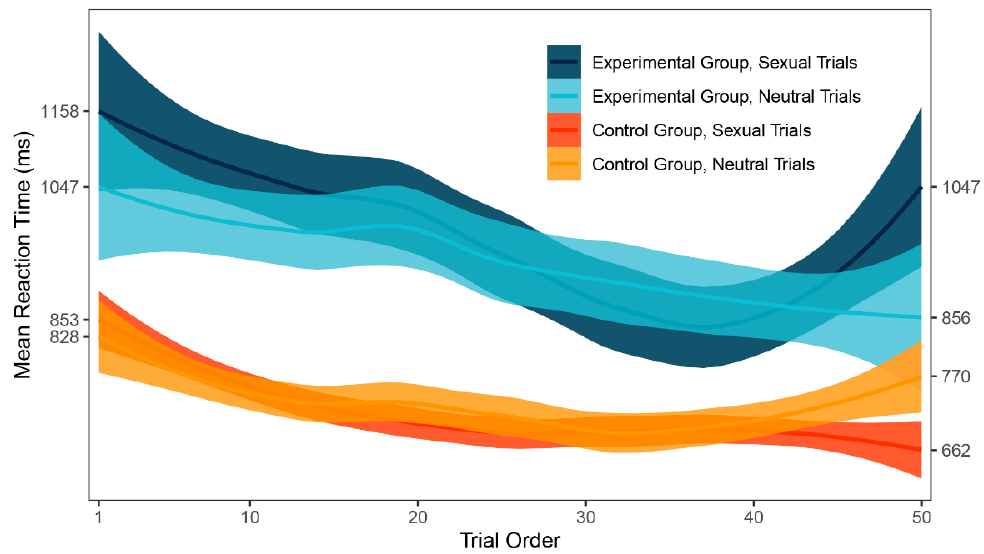
Figure 4. Trial-to-trial performance (ms).